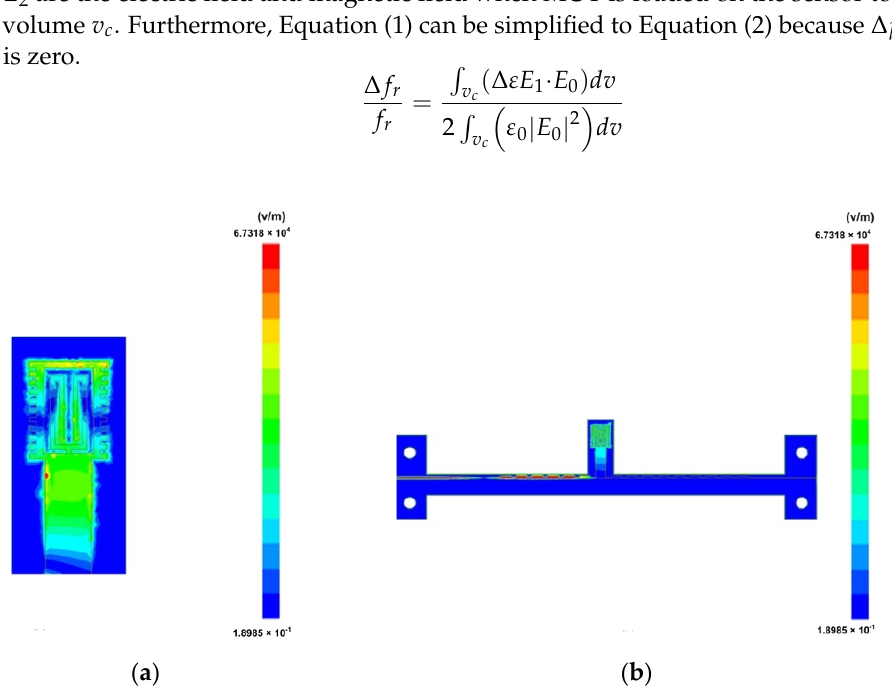
Figure 4. ( a ) Electric field of sensing unit; ( b ) Electric field of transmission line.